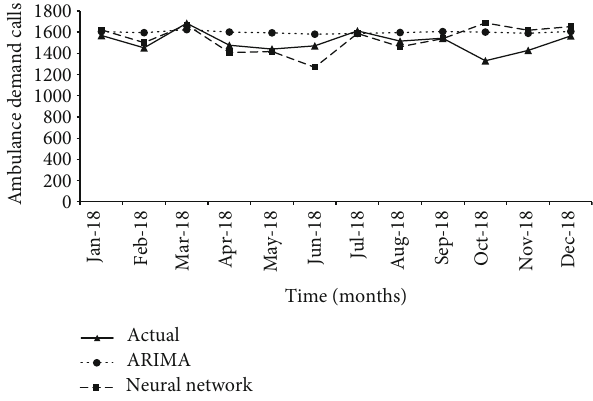
Figure 5: Actual and predicted values of time series